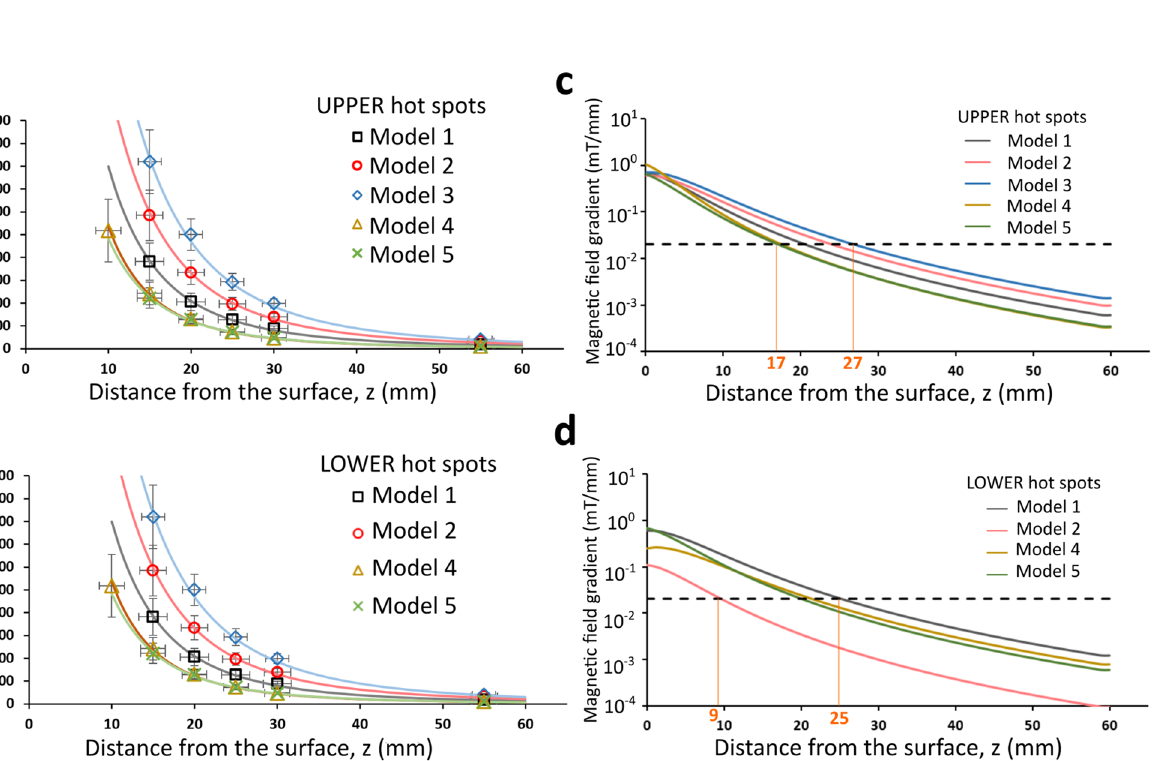
Table 1. Dimensions of the cell phones, location on their screen of the magnetic hot spots (HS), and the maximum field measured at each of them. Magnetic field values are expressed ± U c , the combined uncertainty (see “Methods” for details).